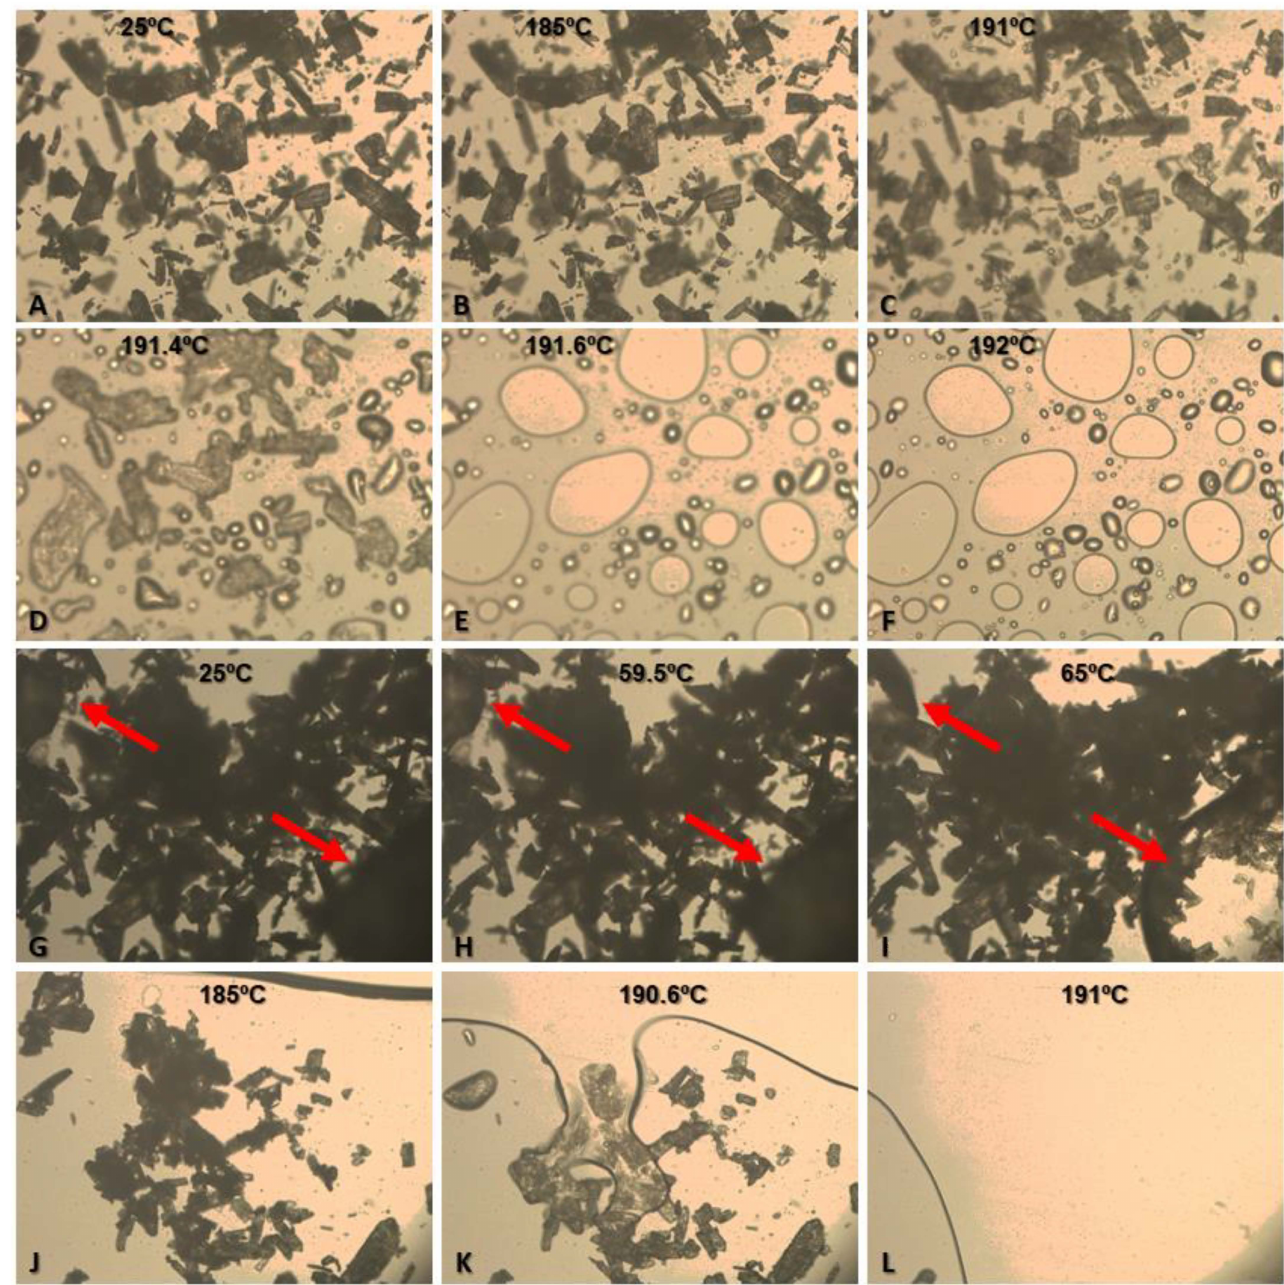
Figure 5. Thermo-optic analysis of benznidazole ( A – F ) and analysis of the physical mixture of PCL and benznidazole ( G – L ). The red arrows indicate particles of the PCL polymer. Treatments with subcutaneous BZ–PCL implants or with crushed tablets administered per os were able to prevent animal mortality, while the group of untreated and infected mice reached 100% mortality by the 18th day post-infection. Both treatments induced suppression of parasitemia at similar periods: 1.43 ± 0.77 days after oral administration for BZ and 1.20 ± 0.45 days after BZ implant SC insertion. Importantly, parasitemia reactivation was not detected in the interval of oral treatment and implant insertion. Oral standard treatment (100 mg/kg/day for 20 days) induced a cure in 57.1% (4 out of 7) of infected animals. When this same dose was administered via implant (BZ–PCL1), no cure was detected. In contrast, in 40 days of treatment with just an implant (BZ–PCL 3), or the combined protocol of 10 days by oral administration plus 30 days of the implant